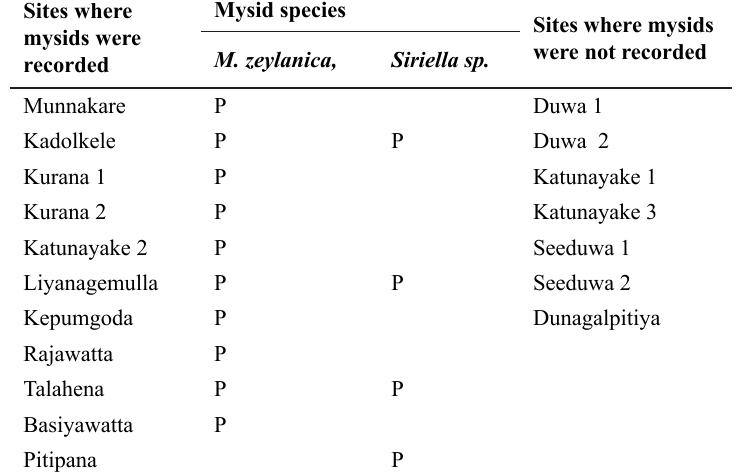
Sites where mysids were not recorded M. zeylanica, Siriella sp.